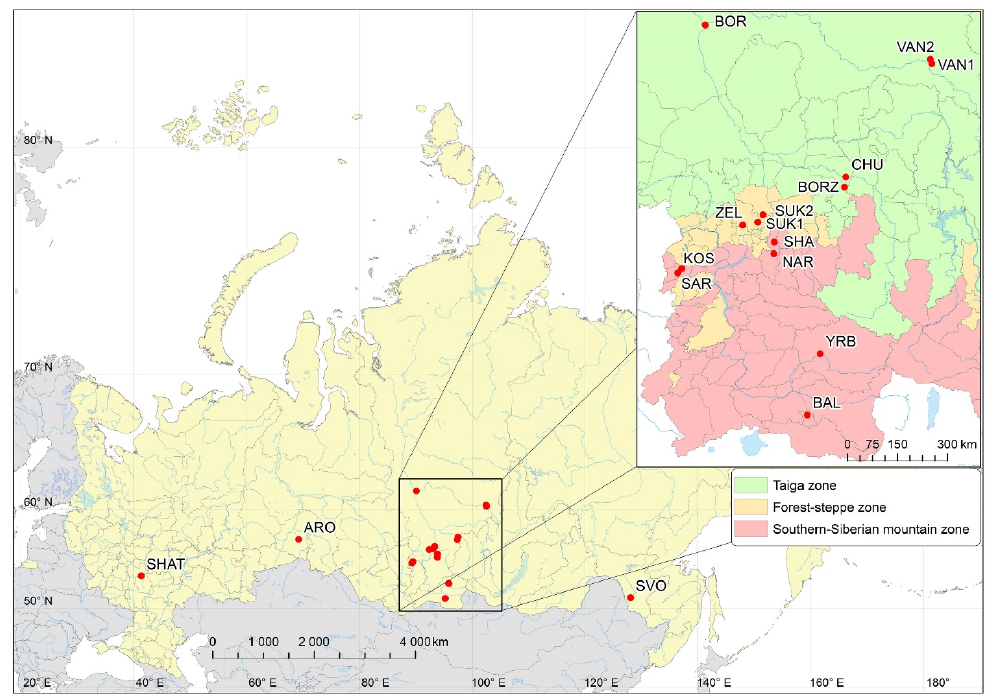
Figure 1. Map of Russia showing the geographic locations of the studied 17 Scots pine populations (acronyms are as in Table 1). Table 1. Geographic location of 17 Scots pine populations across Russia .